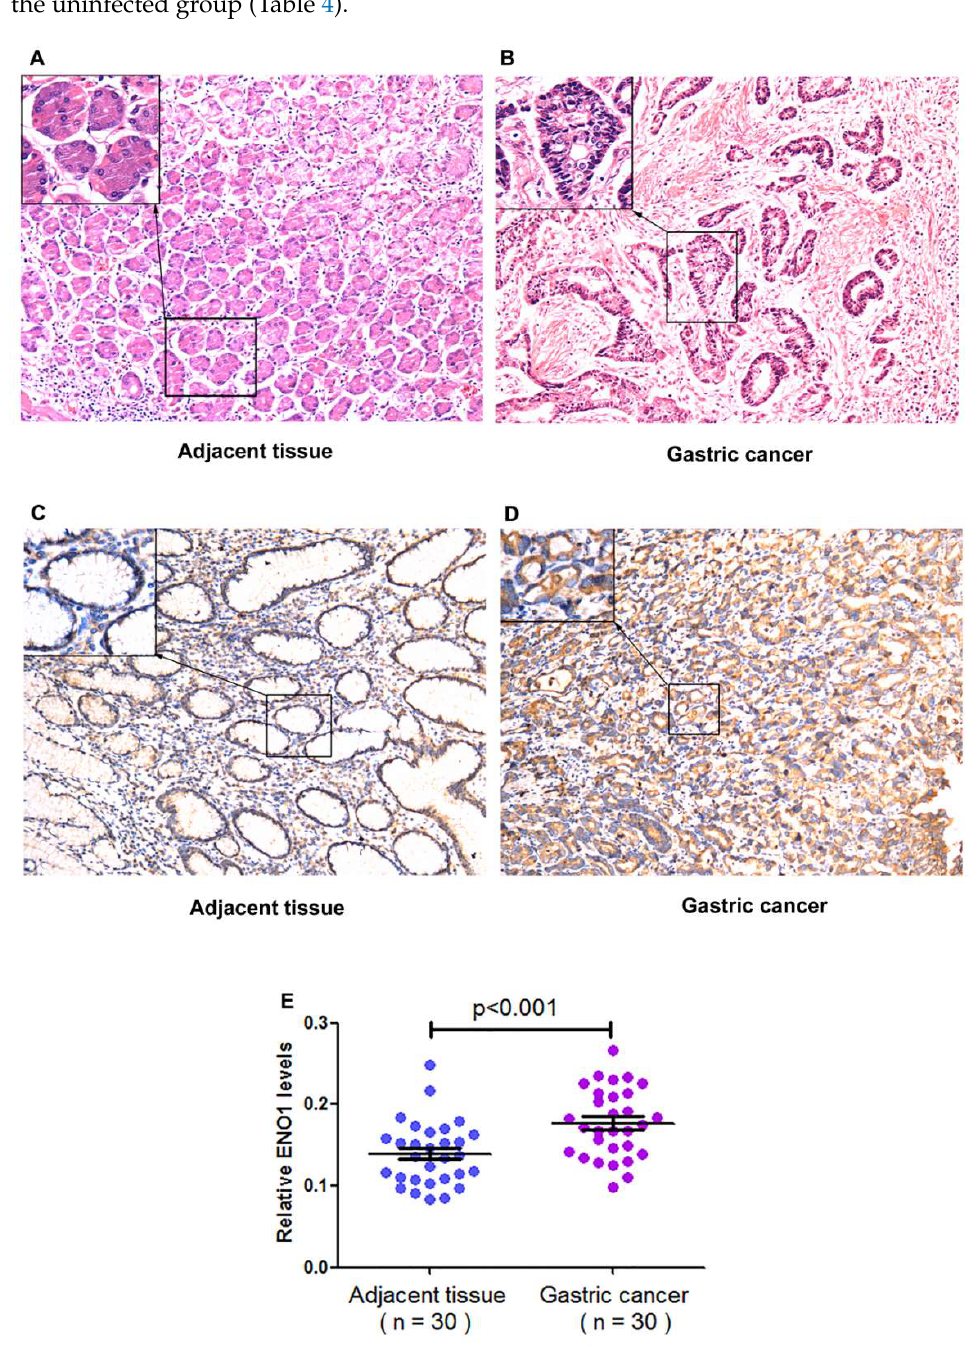
Figure 1. Comparison of gastric cancerous and paracancerous tissues. ( A , B ) Gastric adjacent and cancer tissues embedded in paraffin and stained with hematoxylin and eosin (HE). ( C , D ) Gastric paracancerous and cancerous tissues embedded in paraffin and stained using the immunohistochem- ical method. Rabbit anti-ENO1 antibody was used as the primary antibody with a rabbit anti-actin antibody as the control, and radish peroxidase-labeled goat anti-rabbit IgG antibody as the secondary antibody. The positive reaction was visualized using DAB, and the tissue section was re- stained with Harris’ haematoxylin. ( E ) Optical density of the stained gastric cancer sections (n = 30) and paracancerous tissues sections (n = 30) measured using the software ImageJ.